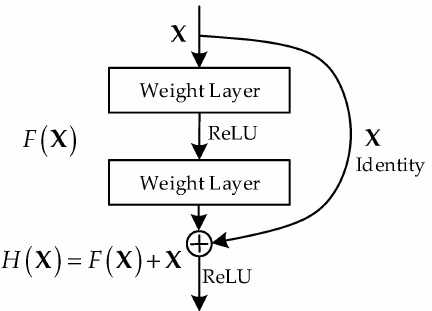
Figure 2. Illustration of a basic residual learning block (ResBlock)